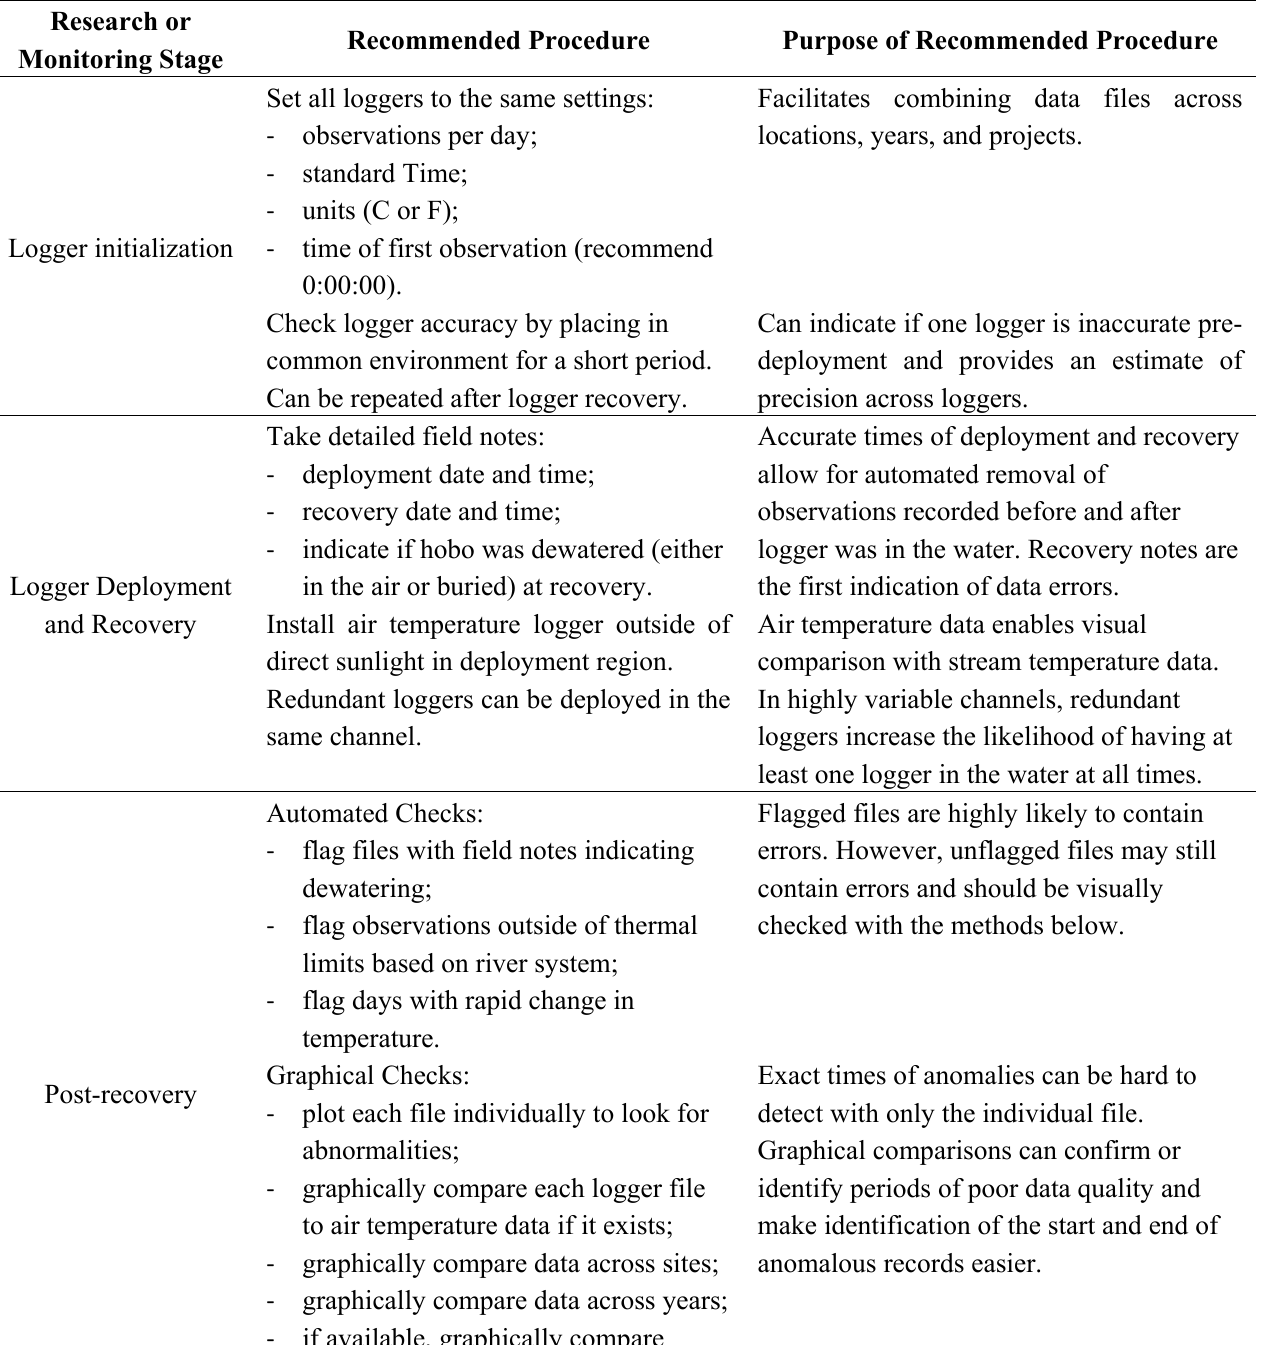
Table 1. Steps for maximizing quality of water temperature data collected using remote field